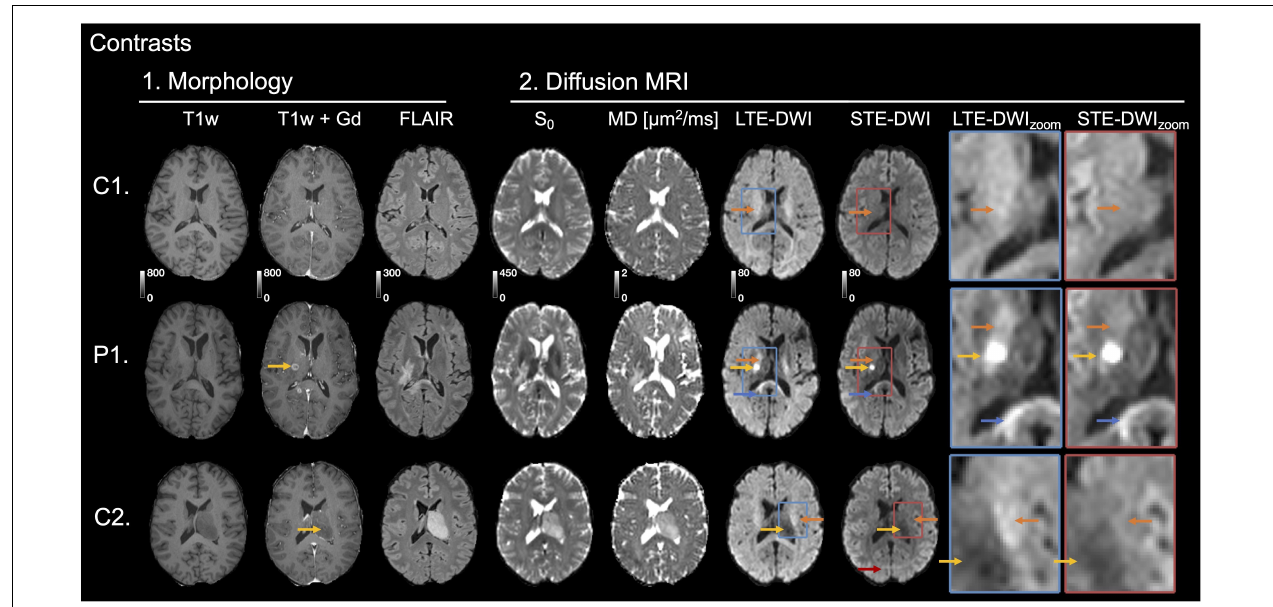
FIGURE 1 | Investigated image contrasts. Three contrasts were related to morphology: T1w, T1w contrast-enhanced by Gadolinium (T1w+Gd), and T2w FLAIR. Four were related to DWI: S 0 , mean diffusivity (MD) and high b -value diffusion-weighted imaging (DWI) ( b = 2,000 s/mm 2 ) obtained with linear tensor encoding (LTE) and spherical tensor encoding (STE). Insets to the right show zoomed-in versions of LTE-DWI (blue frame) and STE-DWI (red frame). To simplify the comparison between STE-DWI and LTE-DWI, the signal intensities of the zoom-ins were averaged to the same average intensity value, but zoom-outs had the same signal intensity windows (this applies also to Figures 4 , 5 ). The top row shows images from a male (C1) without MRI abnormalities except for vascular malformation (telangiectasia) in the right temporal lobe outside of evaluated regions. The second row shows a patient (P1, male, 52 years), who had an astrocytoma of grade II [mutated; isocitrate dehydrogenase (IDH)] in a similar slice as C1. The MRI was performed to confirm tumor progression. On the post-Gd contrast-enhanced T1-w image, an enhancing lesion can be seen (marked with yellow arrow). Both LTE-DWI and STE-DWI show a tumor-related hyperintensity (yellow arrows), but only STE-DWI attenuates the white matter surrounding the tumor (orange arrows). Apart from the obvious lesions, there is another hyperintensity with similar appearance on both LTE-DWI and STE-DWI (blue arrows). The third row shows the second patient example (C2, male, 57 years), who had a WHO IV glioblastoma (IDH wild - type). The tumor is non-enhancing on contrast-enhanced T1w+Gd image (yellow arrow) and does not show any tumor-related hyperintensity on neither LTE-DWI nor STE-DWI. However, the white matter tracts shifted by the adjacent tumor are attenuated with STE-DWI, but not LTE-DWI (orange arrows). Red arrow points to a fat artifact that is also visible at the same location in other